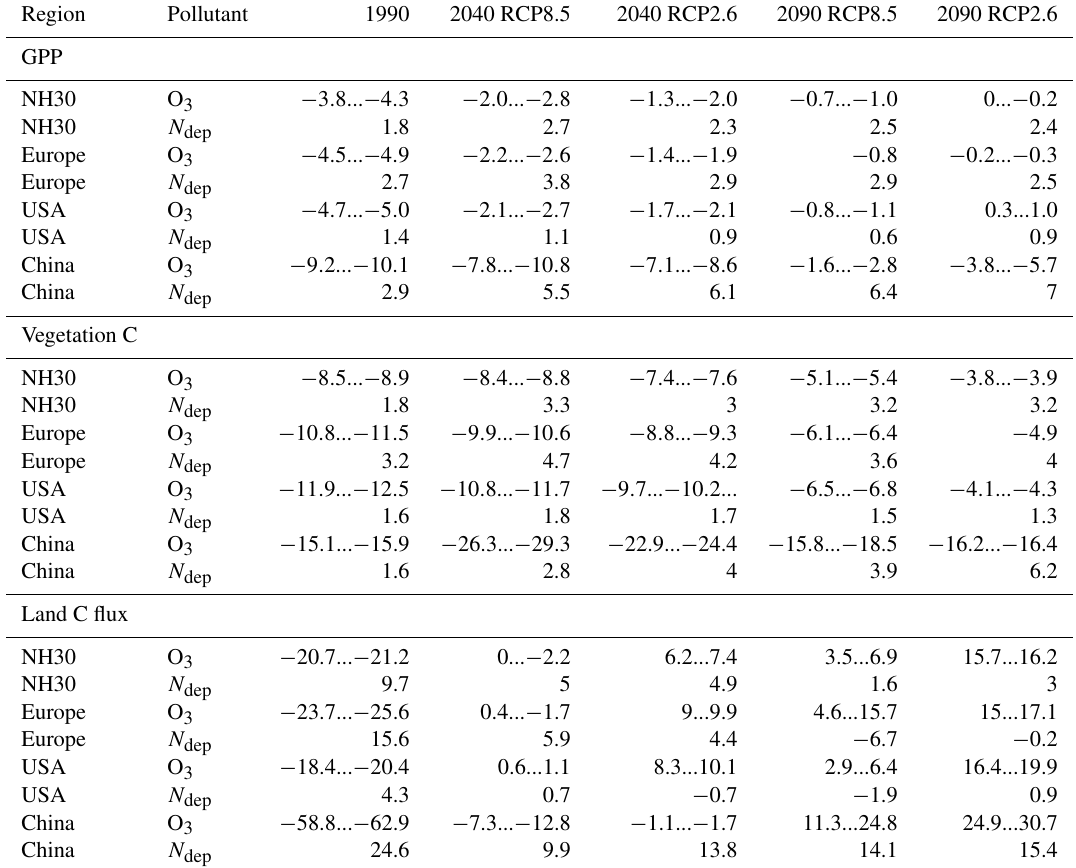
Table 4. Mean percent change in GPP, total carbon biomass in vegetation (vegetation C), and land carbon flux (land C flux) induced by O 3 during the decades of 1990 (1990–1999), 2040 (2040–2049), and 2090 (2090–2099) compared to preindustrial values for the Northern Hemisphere north of 30 ◦ N (NH30) for Europe, USA, and China. The given range indicates the estimates according to both approaches for calculating the O 3 impact. The spread in the effect sizes due to interannual variability, derived from error propagation of the yearly estimates, is displayed in Table